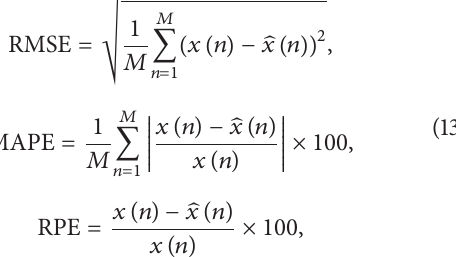
where 𝑥(𝑛) is the actual value at month 𝑛 , ̂𝑥(𝑛) is the predicted value at month 𝑛 , and 𝑀 is the corresponding number of testing (validation)